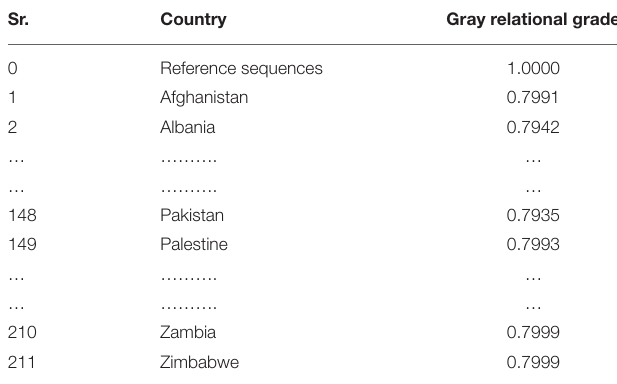
TABLE 7 | Gray relational grades.